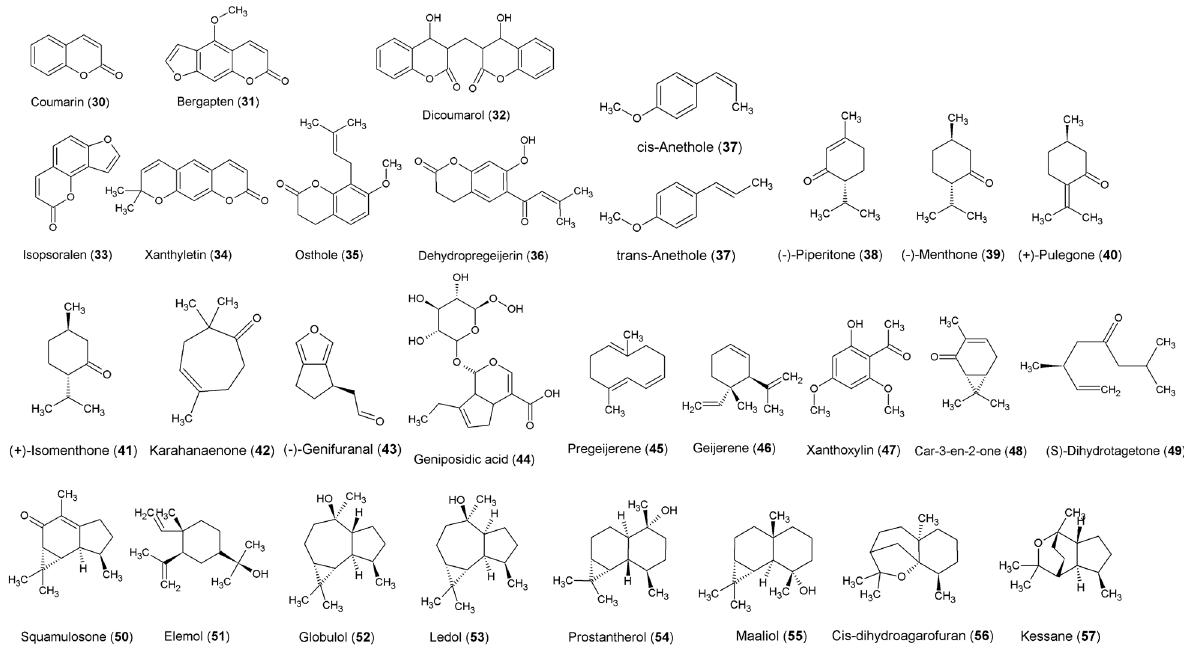
Figure A1. Chemical